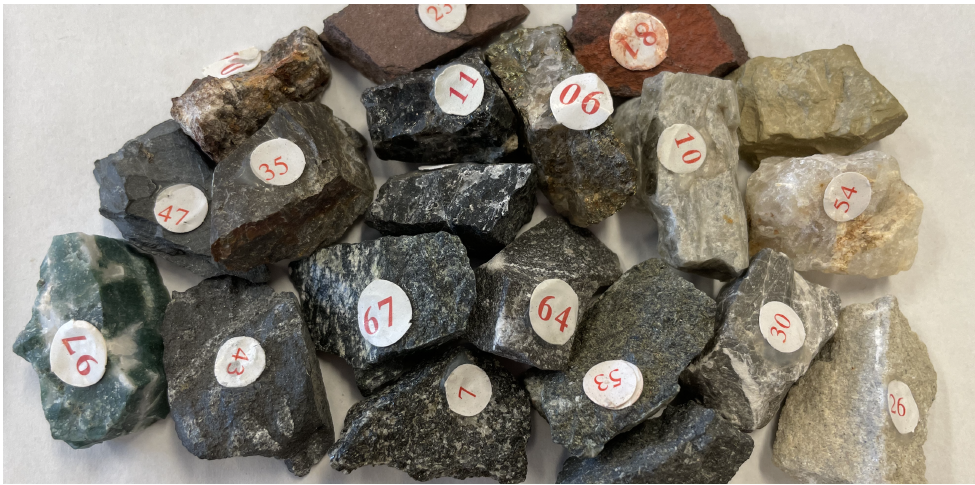
Figure 12. Stone samples. Samples of stones showing inter-class similarity in terms of their visual